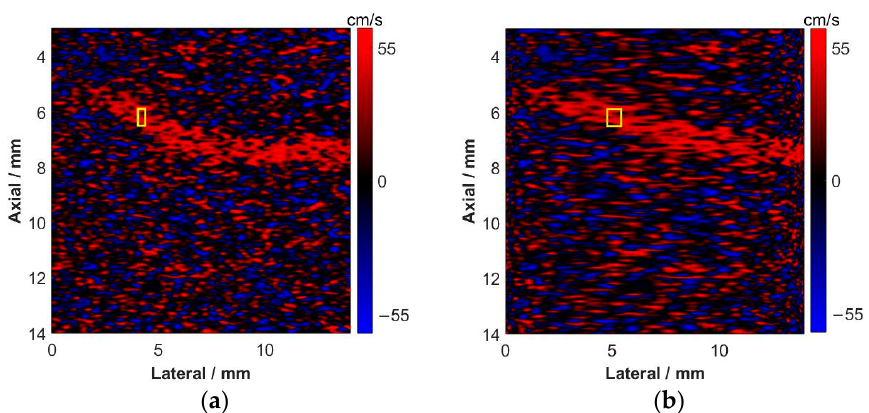
Figure 14. Flow image information calculated with color flow Doppler: ( a ) original image without motion compensation and ( b ) the compensated image. The yellow rectangular area was used to measure the average blood velocity.